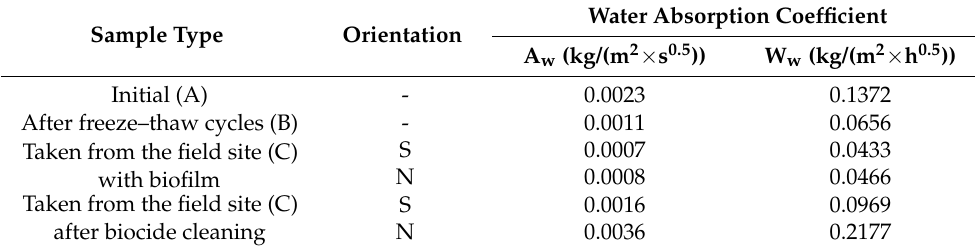
Table 1. Water absorption coefficient of mineral-based